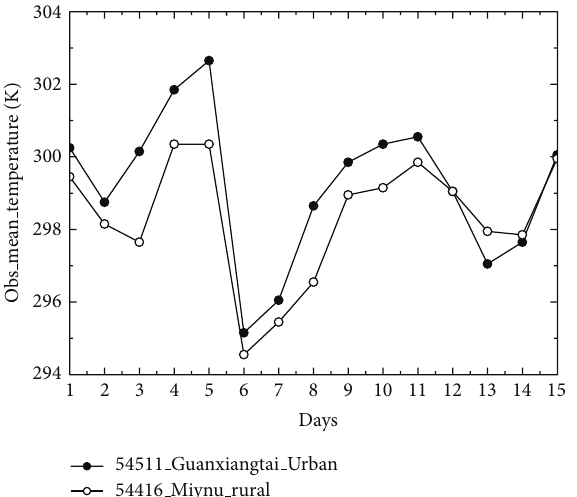
Figure 4: Comparison of the observed daily mean air temperature between the Guanxiangtai and Miyun stations from 01 to 15 July, 2003. The black filled circle line represents the observed temperature at the Guanxiangtai station, and the black open circle line represents the temperatures at the Miyun